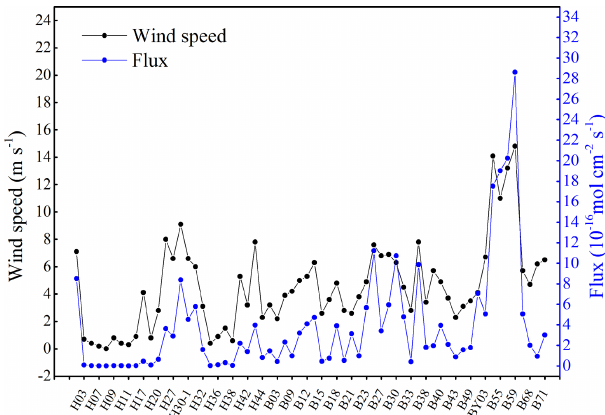
Figure 5. Wind speeds and flux densities of NO in the Bohai Sea and the Yellow